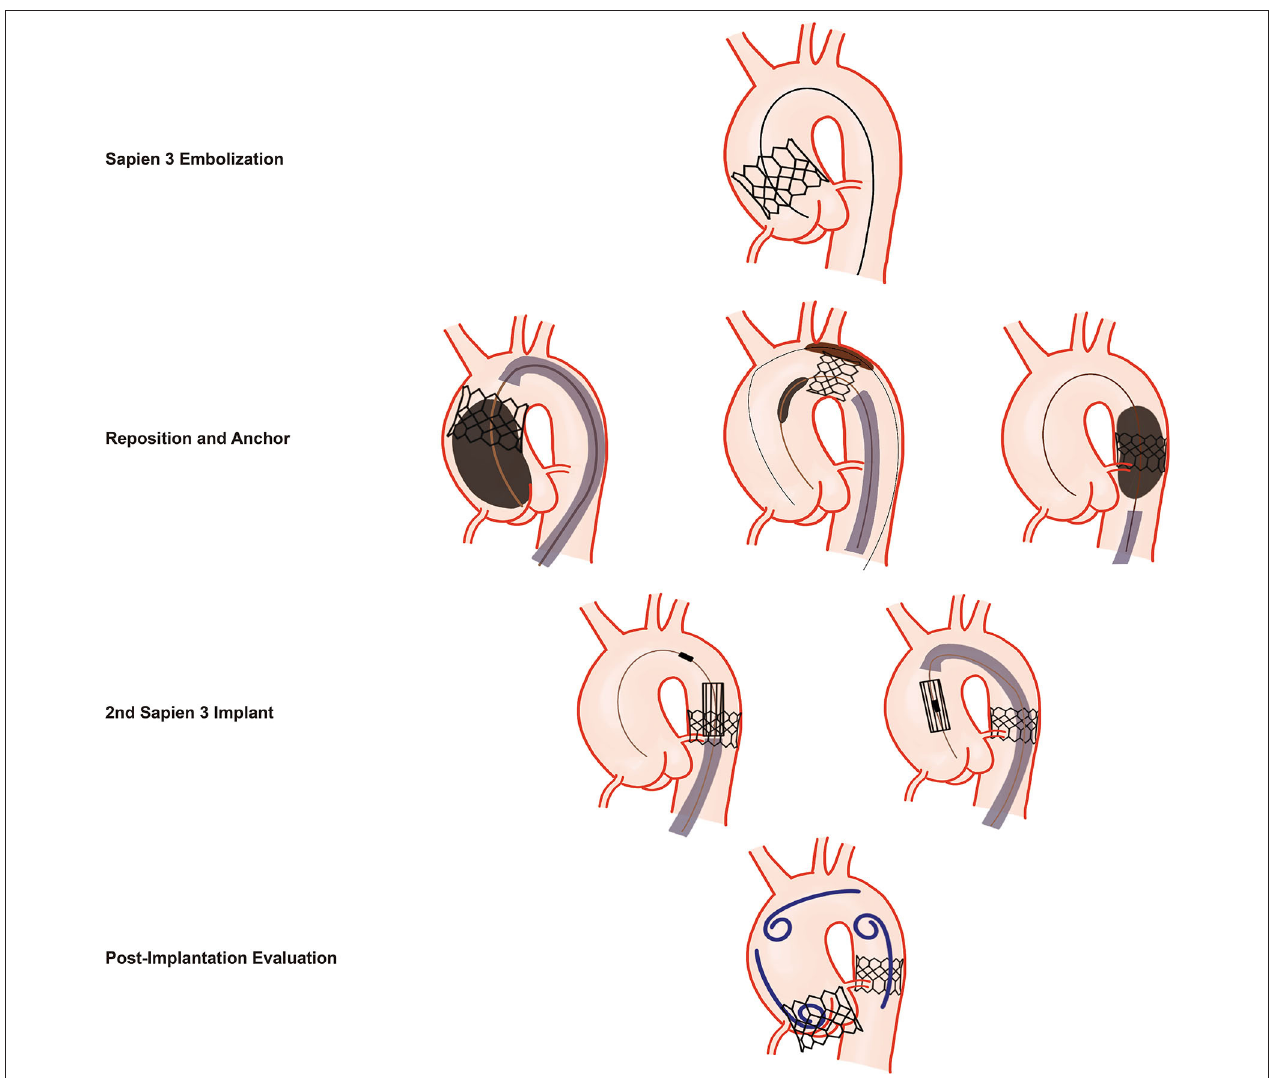
FIGURE 5 | Management of Sapien 3 THV Embolization. Schematic illustration of the management of a Sapien 3 THV embolization. First, repositioning and anchoring of the embolized Sapien 3 THV into the descending aorta with minimally invasive approaches are performed. Second, implantation of the second Sapien 3 THV with maximal centralization of the delivery system when crossing the embolized Sapien 3 THV. Third, angiography of the aortic root, the aortic arch, and the descending aorta is performed to evaluate THV function, patency of the brachiocephalic arteries, and the stability of the embolized valve in the descending